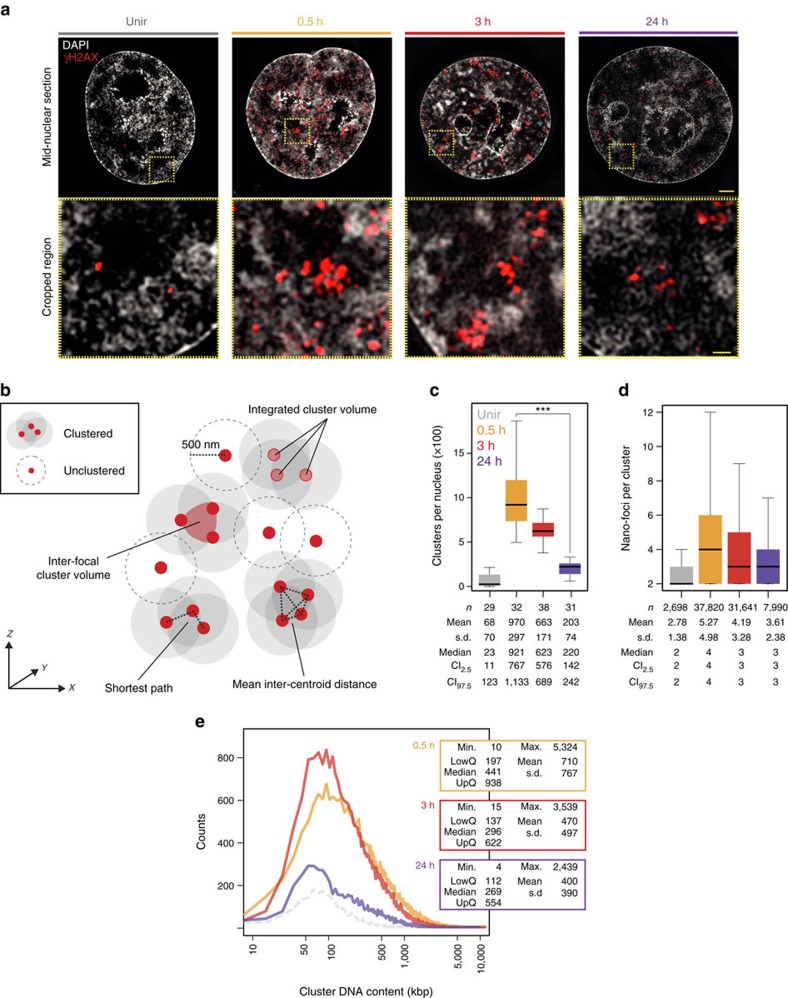
Analysis of γH2AX nano-foci spatial clustering.(a) Exemplary 3D-SIM images of γH2AX immunofluorescence before and during DDR. Shown are the mid-nuclear section with DAPI and γH2AX signals, and magnified view from the yellow frame. Scale bars, 2 μm and 400 nm for main micrographs and magnified regions, respectively. (b) Schematics of γH2AX 3D-clusters analysis. All centroids (red dots) within a sphere defined by a given cutoff radius (500 nm in further analysis) are included in a cluster. For all nano-foci belonging to each given cluster, the sum of the volume of single nano-foci (integrated cluster volume), the volume delimited by the centroids (inter-focal volume), the shortest path connecting all centroids as well as the mean distance between centroids (mean inter-centroid distance) are computed (Supplementary Fig. 6C–F). (c) γH2AX 3D-clusters per nucleus. One-way ANOVA with Dunnett's correction; ***P<10−3. (d) γH2AX nano-foci per 3D-clusters. Kruskal–Wallis χ2=1,926.3, df=3, P<2.2 × 10−16. (e) DNA content distributions of γH2AX 3D-clusters during DDR. The DNA content of each nano-focus belonging to a given cluster is summed. The dashed line depicts the distribution of γH2AX 3D-clusters before IR. Kruskal–Wallis χ2=5,964.1, df=3, P<2.2 × 10−16. Statistics are presented as in Fig. 2. All boxes and whiskers are as in Fig. 1. n: number of analysed cells (c) or 3D-clusters (d).